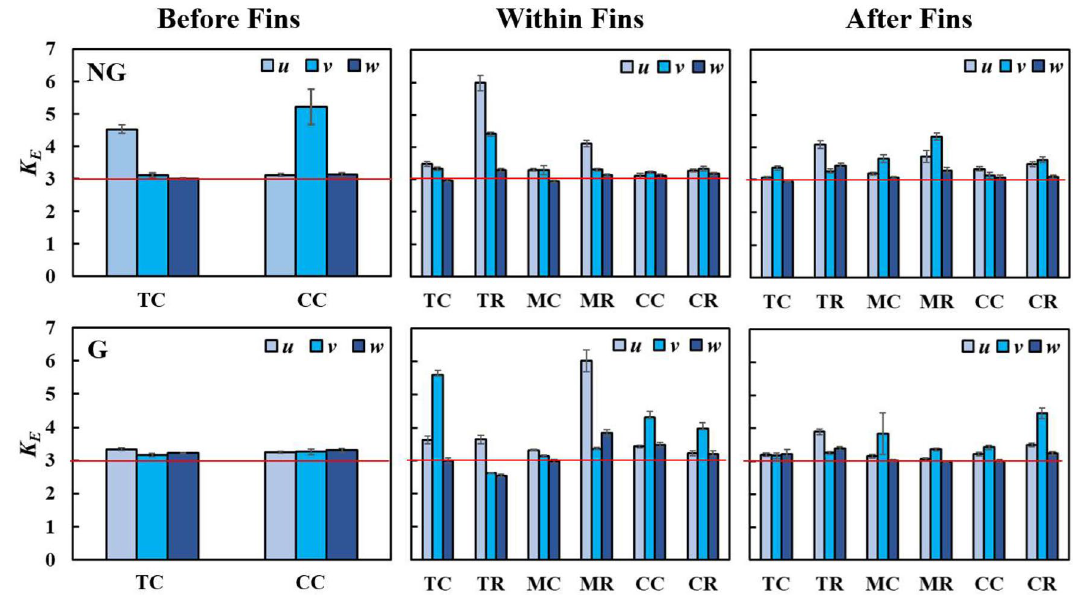
Figure 13. Equivalent kurtosis of velocity fluctuations along streamwise u , spanwise v and cross-stream w for NG (top row) and G (bottom